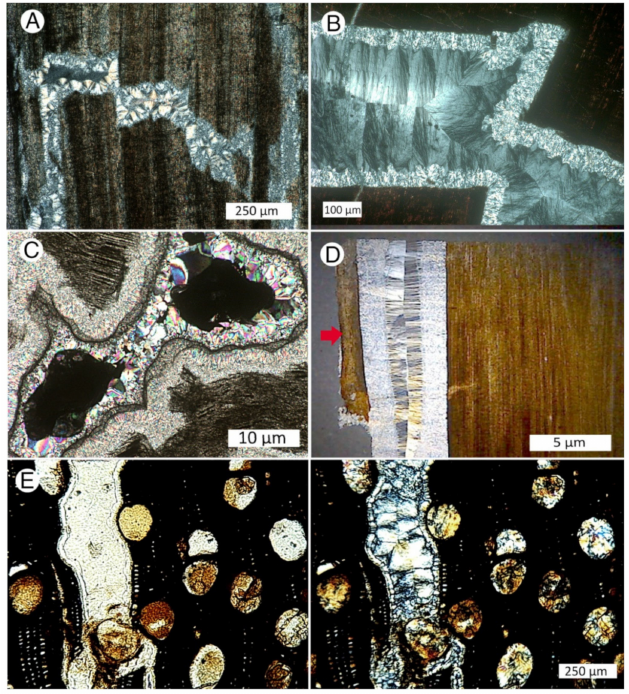
Figure 36. Fossilized wood containing open spaces that become sites for silica precipitation after the adjacent cellular tissue had been mineralized. ( A ) Polarized light view of a fracture containing chalcedony in Eocene wood, Yellowstone River, Montana, USA. The open fracture was offset prior to chalcedony formation, evidence that the surrounding mineralized wood had reached a stage of brittleness. ( B ) Polarized light view of an offset fracture in Eocene fossil wood from Blue Forest, Eden Valley area, Wyoming, USA. Silica precipitation in the fracture occurred in two stages, beginning with a thin microcrystalline layer coating the fracture walls, followed by formation of fibrous chalcedony that filled the remaining space. This chalcedony grew inward from the fracture walls, as evidenced by a central midline where the two layers met. ( C ) Polarized light image of a decayed region in Miocene fossil wood from Goose Creek, northern Nevada, USA. The cavity wall has a thick layer chalcedony covered by quartz crystals. The cavity center area remains unmineralized. ( D ) Chalcedony fills an open space in Miocene wood where desiccation caused the bark (marked with arrow) to separate from the interior wood. Eocene Blue Forest locality, Eden Valley area, Wyoming, USA. Polarized light view. Specimen provided by Mike Viney. ( E ) Thin section view of Miocene wood from Georgia nation Transverse view shows vessels mineralized with opal-CT, and a fracture that contains two generations of chalcedony. Polarized light view on right. Specimen provided by Mirian